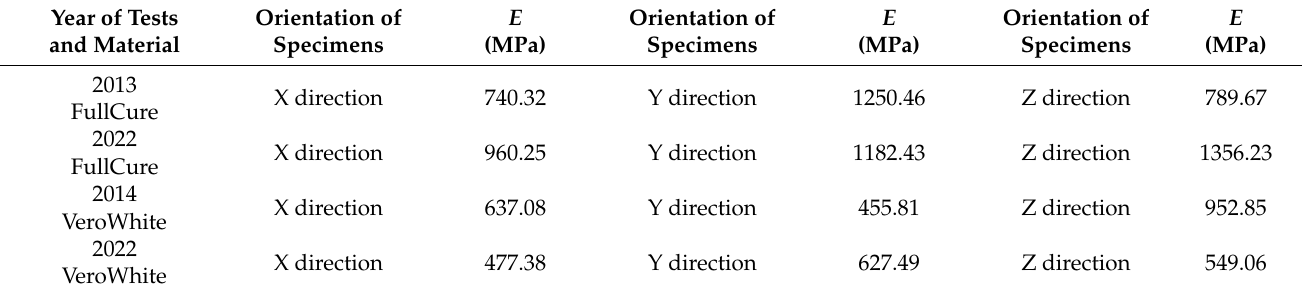
Table 4. Mean values of the modulus of elasticity in MPa for as-printed and naturally aged specimens made of FullCure 720 and VeroWhite polymers.